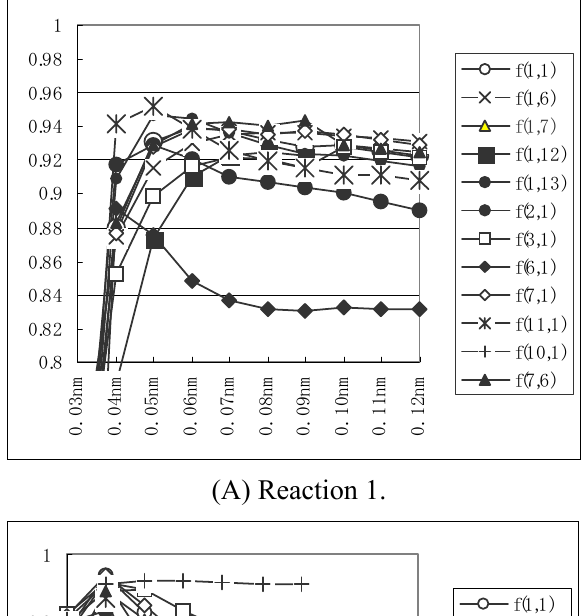
Figure 1. The R vs. r